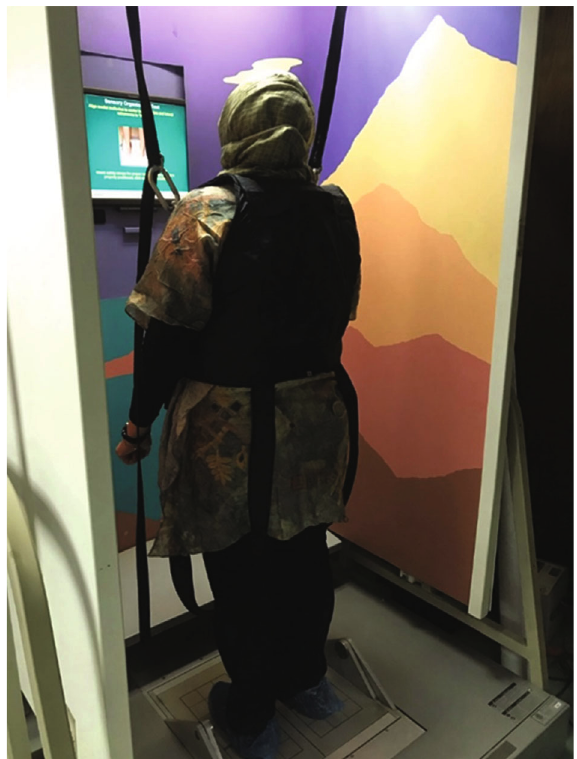
Figure 5: Patient on dynamic posturography